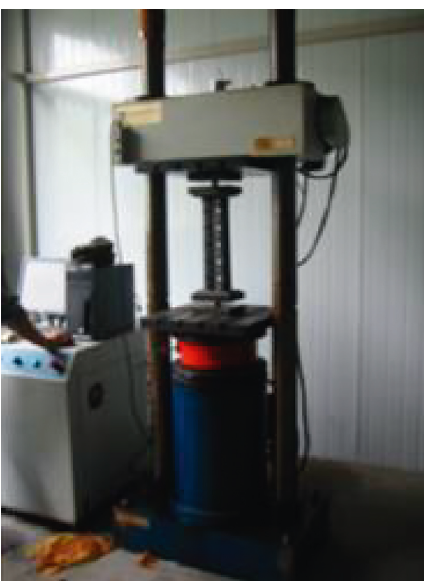
Figure 3: The experiment setup and supporting system of EN15512